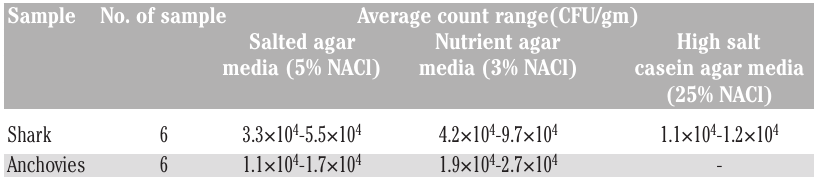
Table 2. Growth of microorganisms isolated from Scoliodon sp. and Thrissina thryssa . Sample No. of sample